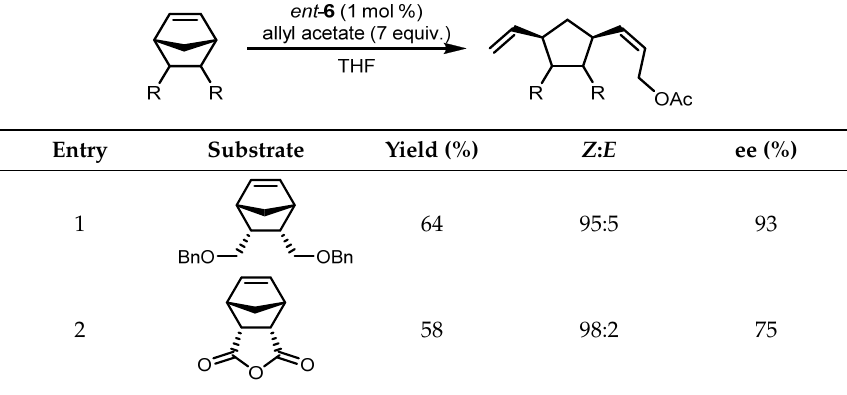
Figure 13. Curtin-Hammett effect of Fischer carbene in asymmetric ring-opening/cross metathesis (AROCM). ( a ) AROCM proceeding through an exo -intermediate; ( b ) AROCM proceeding through an endo -intermediate. Table 18. Z -Selective AROCM of norbornenes using the ent - 6 .